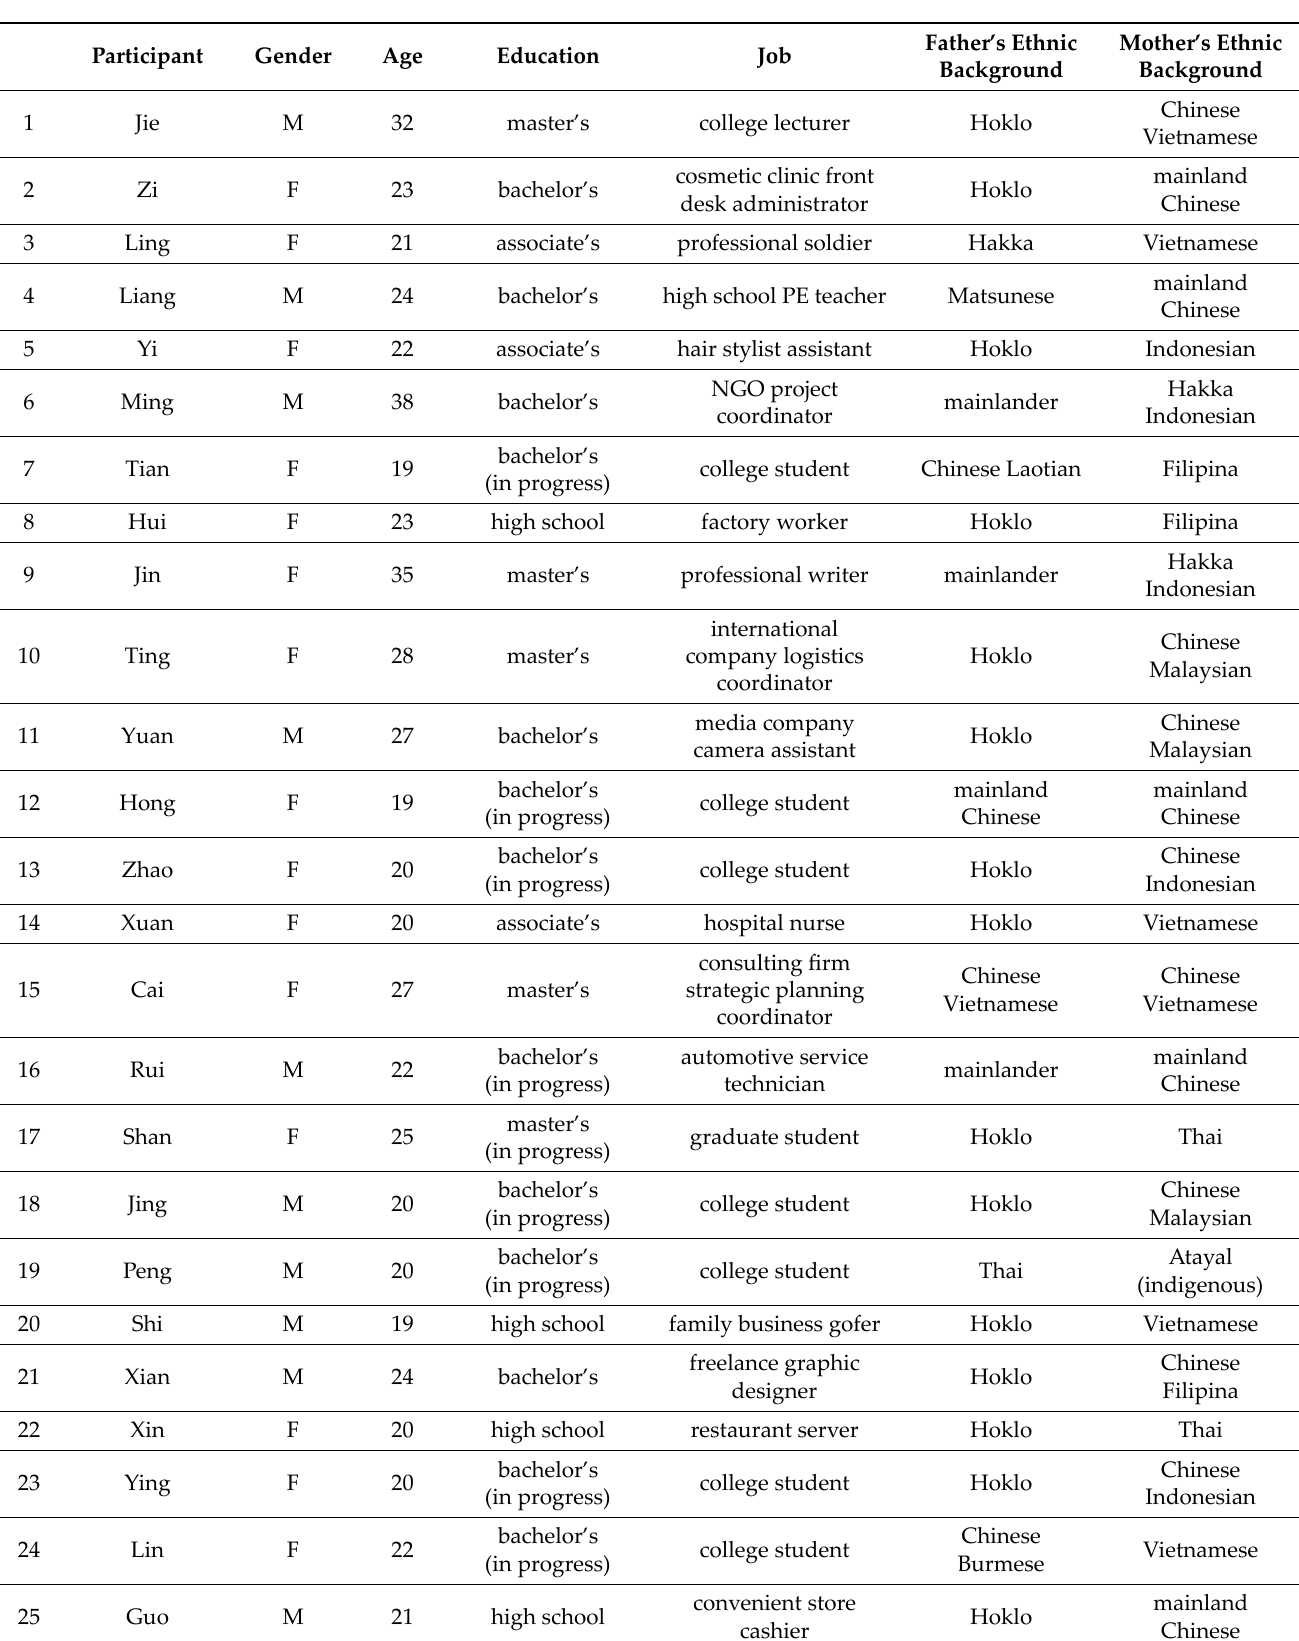
Table 2. Basic demographic information of the interview